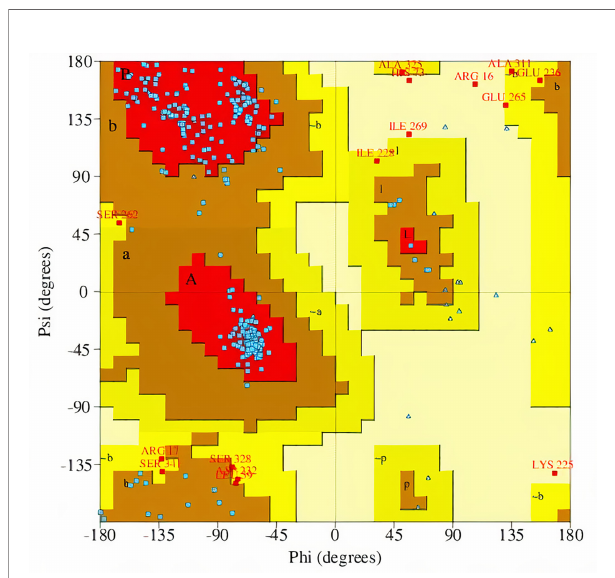
FIGURE 3 | Ramachandran plot of the selected Ld SMT model (MOD4PNE5) obtained via PROCHECK. The percentages of residues in the most favored regions, additionally allowed regions, generously allowed regions, and disallowed regions are 84.9%, 10.3%, 3.5%, and 1.3%,